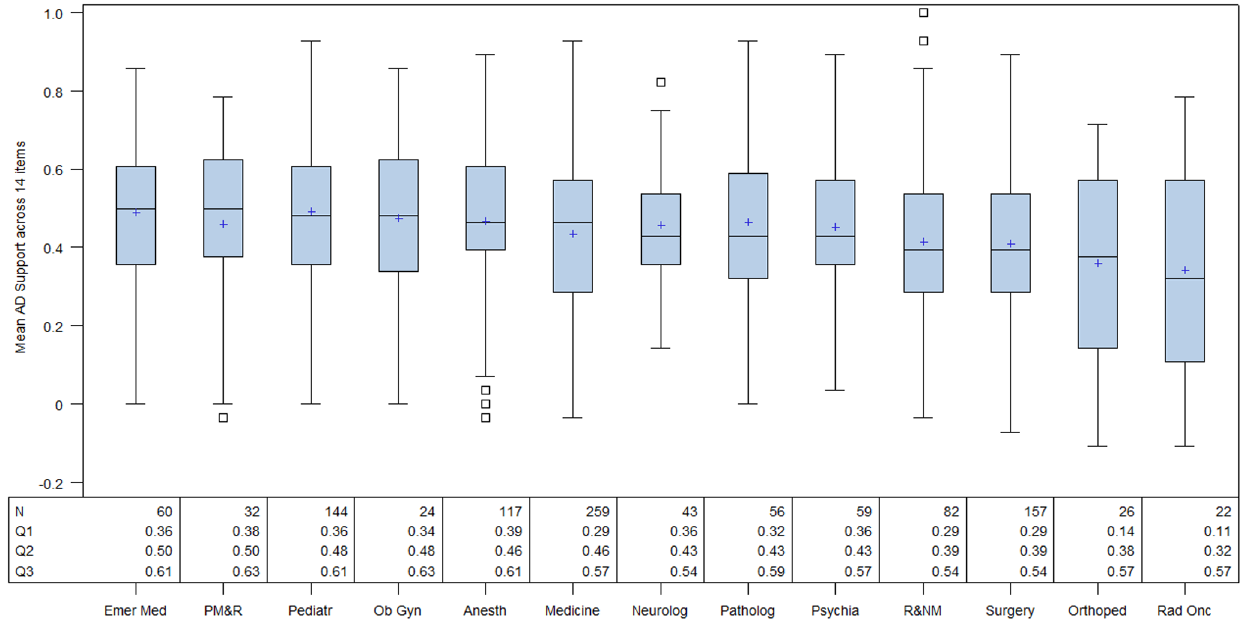
Figure 2. Box and Whisker plots of the 2013 participants sorted by subspecialty and ordered based on median Average Advance Directives Support Score (AADSS). The numbers in each sub-specialty, the 25th percentile (Q1), the median (Q2) and the 75th percentile (Q3) values are shown. The Emergency Medicine sub-specialists have the highest median AADSS score of 0.50 and Radiation Oncology sub-specialists are at a median AADDS of 0.32. Emer Med = Emergency Medicine, PM&R = Physical Medicine and Rehabilitation, Pediatr=Pediatrics, ObGyn= Obstetrics and Gynecology, Anesth=Anesthesiology, Neurolog=Neorology, Pathlog=Pathology, Psychia=Psychiatry, R&NM= Radiology and Nuclear Medicine, Orthoped= Orthopedics, Rad Onc=Radiation Oncology. N=number of participants.